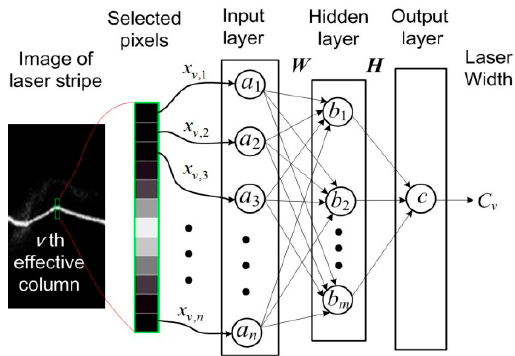
Figure 2. Width computation of cross section profile using back propagation neural network (BPNN).